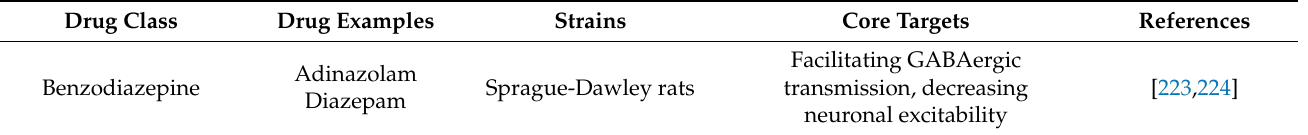
Table 2. Pharmacotherapy of aggression associated with depressive syndrome. Effects of classical an- tidepressants and drugs with antidepressant-like effects are systematized by drug classes, abbreviations are: BDNF—brain-derived neurotrophic factor; GSK3- β —glycogen synthase kinase-3 beta; MAOI—mo- noamine oxidase inhibitor; NMDA—N-methyl-D-aspartate; SNRI—serotonin norepinephrine